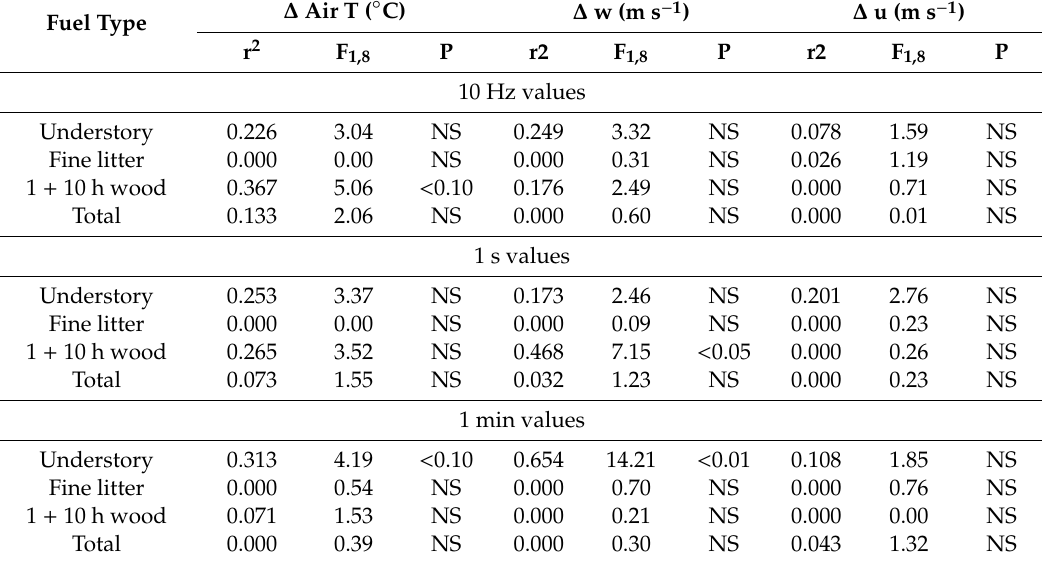
Table 8. Pearson’s product moment correlation coe ffi cients and statistics for the linear relationships between consumed fuels and heat and turbulence statistics during the eight prescribed fires. ∆ Air temperature ( ∆ Air T), ∆ vertical wind velocity ( ∆ w), and ∆ horizontal wind velocity ( ∆ u) are 10 Hz, 1 s, and 1 min maximum di ff erences between burn area and control towers during fire front passage. Statistically significant relationships are highlighted in bold. NS = not